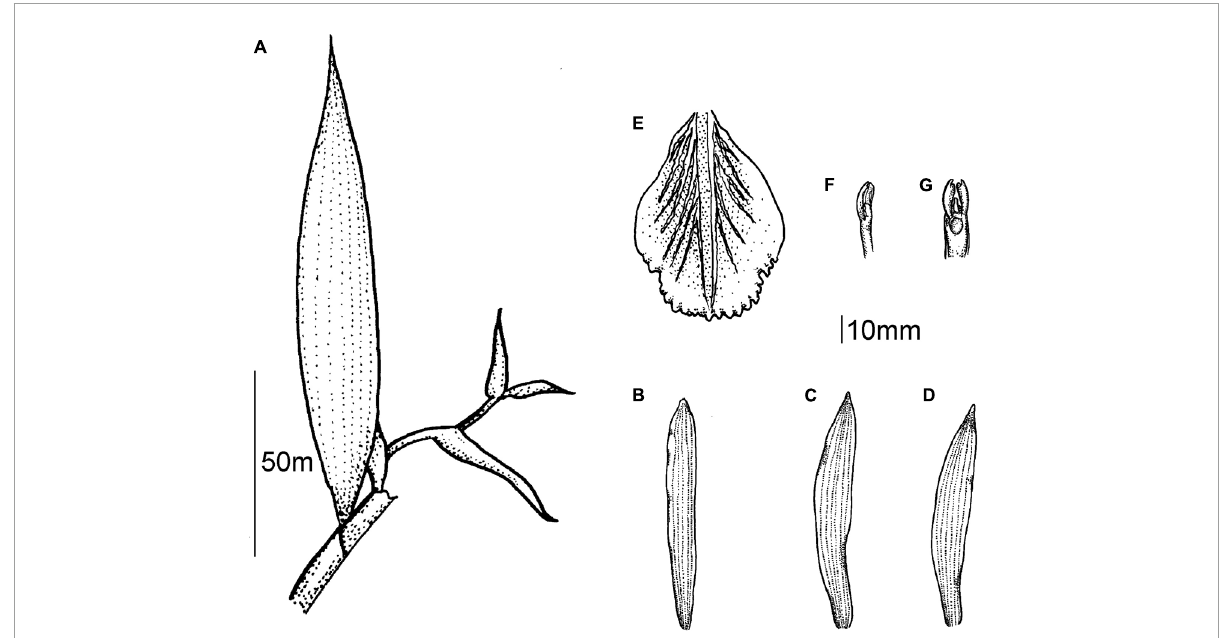
FIGURE2 Sobralia chrysantha Lindl. (A) apical part of stem with inflorescence, (B) dorsal sepal, (C) petal, (D) lateral sepal, (E) lip, (F) apical part of gynostemium, side view, and (G) apical part of gynostemium, front view [drawn by P. Baranow; panels (A,E–G) from the isotype, lip, and gynostemium redrawn from the drawings left on the herbarium sheet; panels (B–D) from Schlim 1188 ].